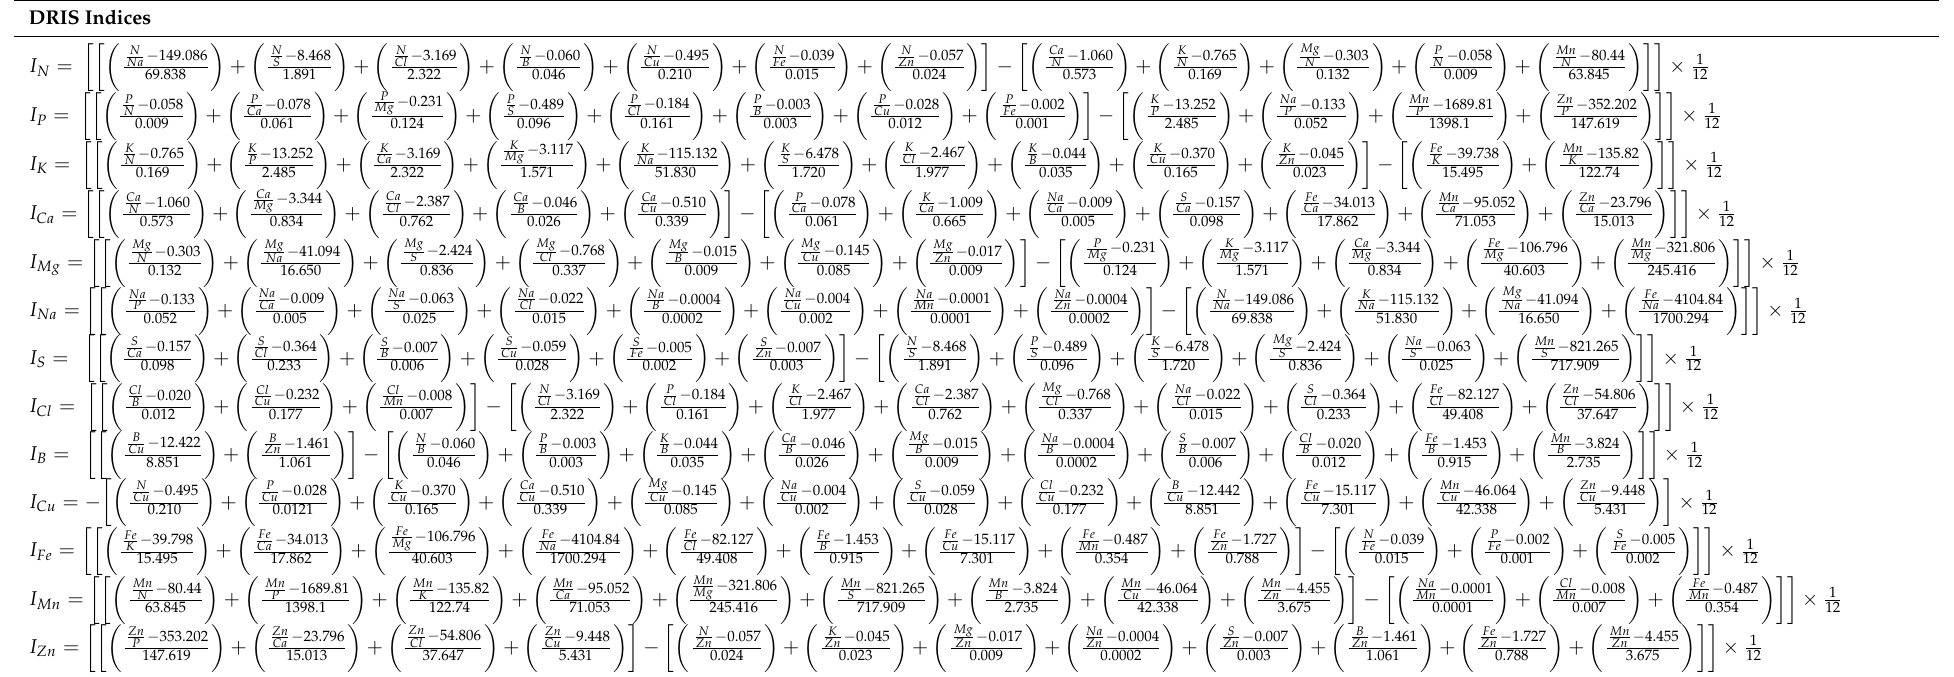
Table 2. DRIS index equations of macro- and micronutrients according to Jones [32], where letters of macro- and micronutrients are related to the sample to analyse